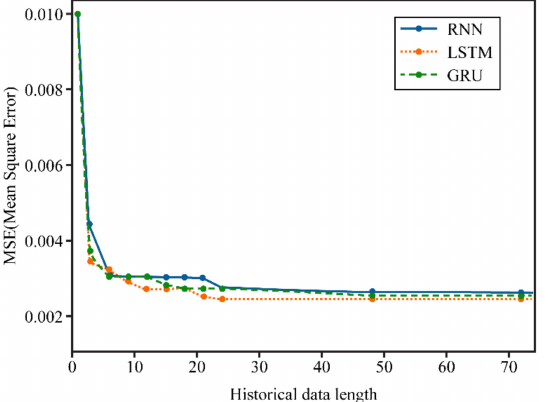
Figure 7. MSE curve according to the past data length of dataset 1. LSTM converges from 24 h, whereas the RNN and GRU converge thereafter. The error rate at LSTM with 24 h past data is the lowest at 0.0024 (Source: